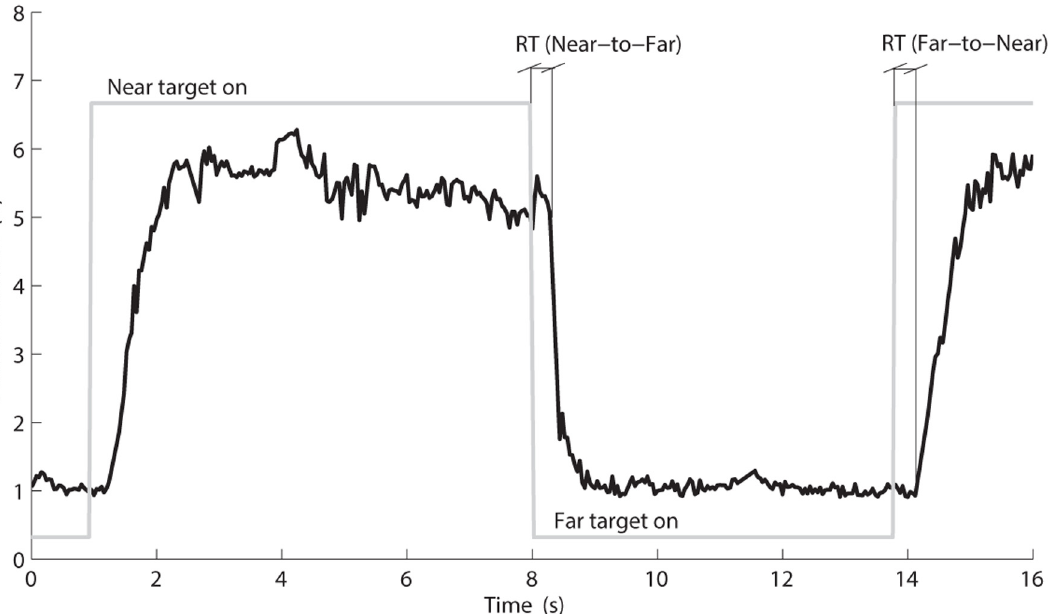
Fig 2. Shift in accommodation from the Near to the Far target. This is a representative shift in accommodation, with the neutral trial lens, from the Near to the Far target and back. The grey horizontal lines show which of the targets that is turned on (Near or Far) and the grey vertical lines depict the shifts between these. RT = Reaction